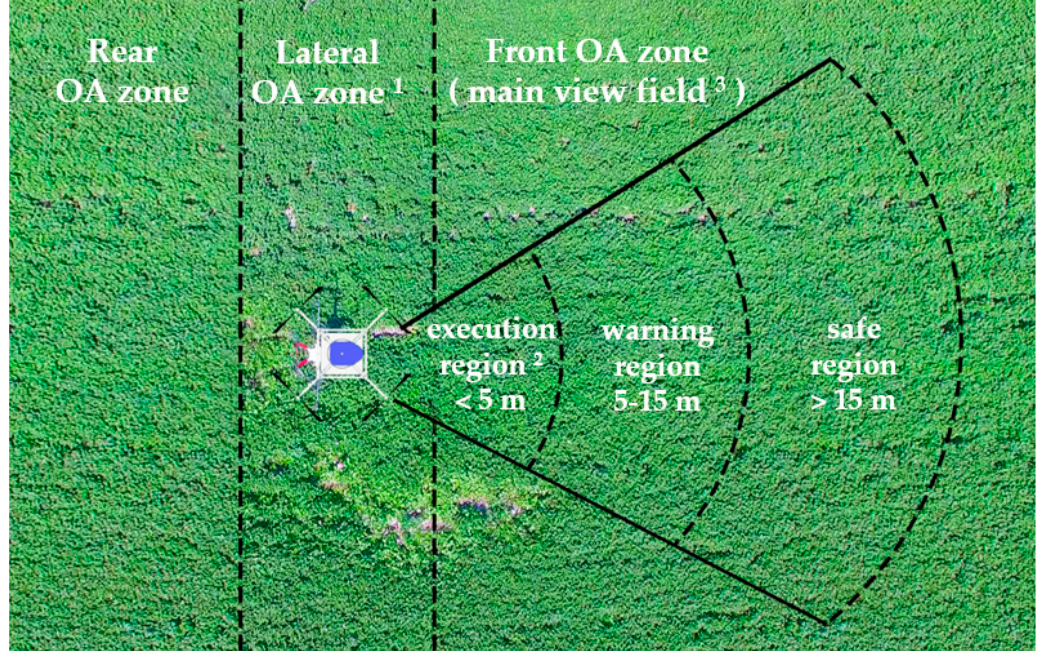
Figure 2. Obstacle avoidance zone of agricultural UAVs. 1 This figure does not express the OA zone in the up and down direction due to perspective. 2 The interval are subject to actual spaying environment and needs. 3 The default main view filed is UAV’s heading direction. Obstacle distance varies with the movement of the agricultural UAVs, and therefore it is relative.